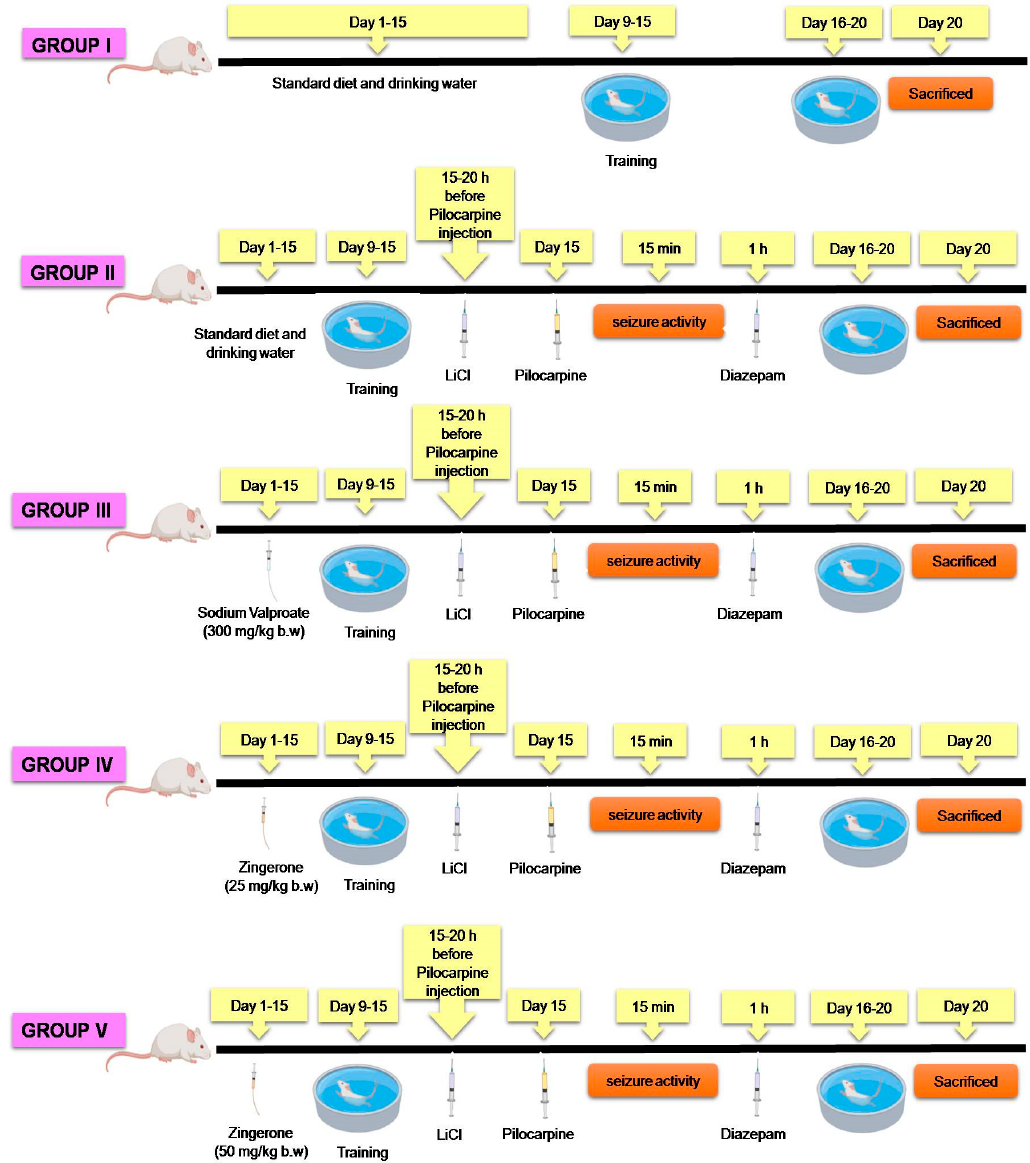
Figure 7. A schematic of status epilepticus induced by pilocarpine treatment protocol. Experimental Regimen